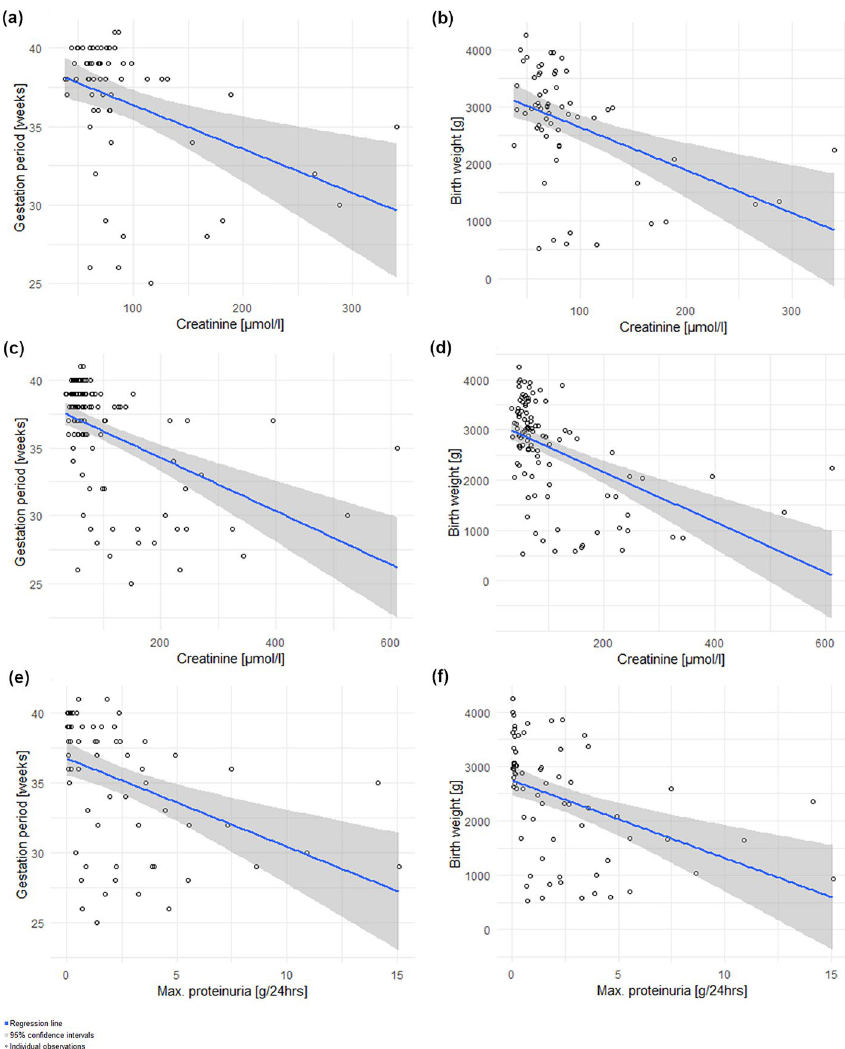
Figure 1. Creatinine and proteinuria